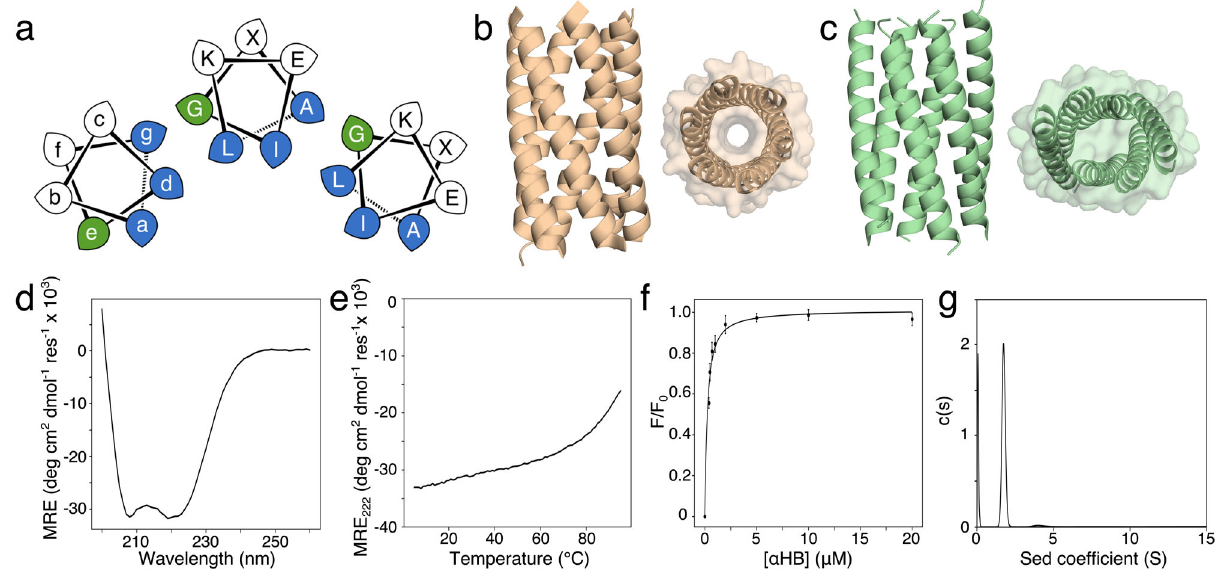
Fig. 1 Design and characterisation of a dynamic coiled coil. a Helical wheel showing the gade interface (blue/green) of Type-2-coiled coils and the heptad repeat of CC-Type2-(L a I d G e ) 4 . The Gly at the g position is highlighted (green). b , c Orthogonal views of X-ray crystal structures of an open hexameric α -helical barrel, CC-Type2-(S g L a I d ) 4 (straw; PDB code 4PN9), and a collapsed hexameric coiled coil, CC-Type2-(L a L d ) 4 (green; 6G6A). d , e CD spectrum (20 °C) and thermal denaturation pro fi le (5 – 95 °C) for CC-Type2-(L a I d G e ) 4 . MRE, mean residue ellipticity; MRE 222 , mean residue ellipticity at 222 nm. f Representative saturation binding curve for binding of diphenylhexatriene (DPH) to CC-Type2-(L a I d G e ) 4 monitored by fl uorescence at 450 nm. Data presented as the mean ± SD; K D = 230 ± 37 nM from n = 5 independent experiments. F / F 0 , fl uorescence intensity ratio. g Sedimentation-velocity (AUC) of CC-Type2-(L a I d G e ) 4 with DPH, following the absorbance of DPH at 350 nm; molecular weight = 19,800 Da, corresponding to 6.2 × monomer mass. c(s), sedimentation coef fi cient distribution. Conditions: d , e 10 μ M peptide; f 2.4 – 120 μ M peptide, 0.1 μ M DPH, 5% v/v DMSO; g 200 μ M peptide, 5 μ M DPH, 5% v/v DMSO. All experiments were performed in phosphate-buffered saline (PBS), pH